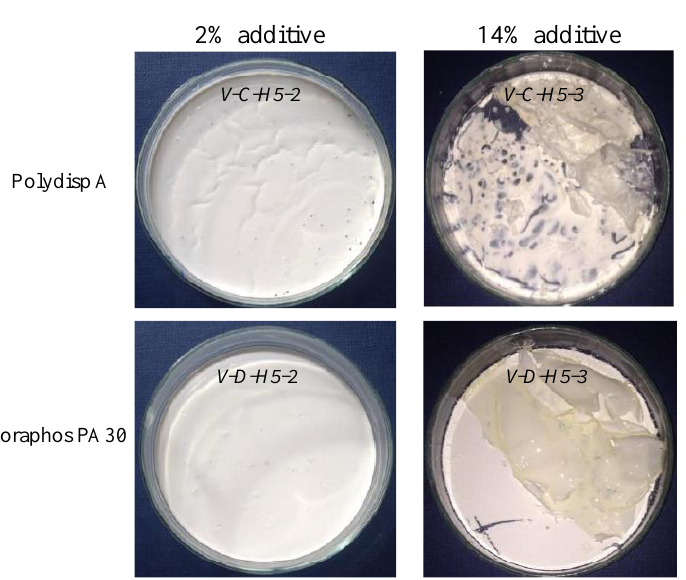
Table 9. LOI measurements of Ecrovin ® LV 340 eco blends with H5 and additives.